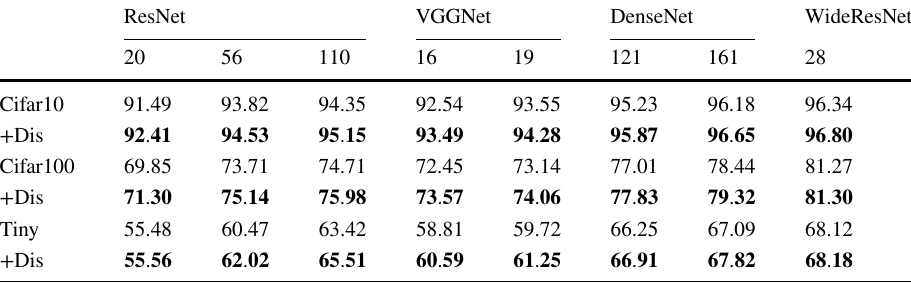
Table 1 Top-1 accuracy(%) with different network types on Cifar10, Cifar100 and Tiny